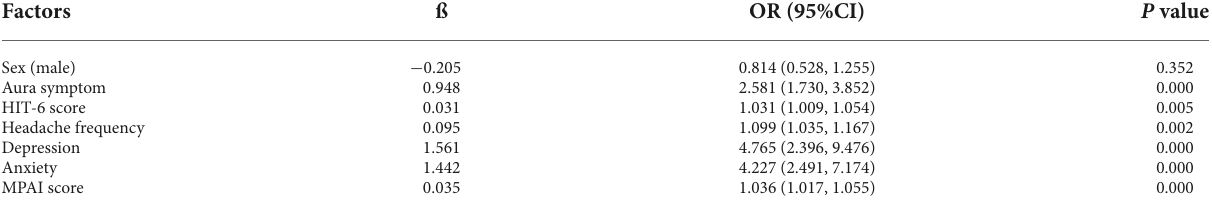
TABLE 3 Univariate logistic regression analysis of contributing factors related to the sleep quality in participants with migraine. Factors